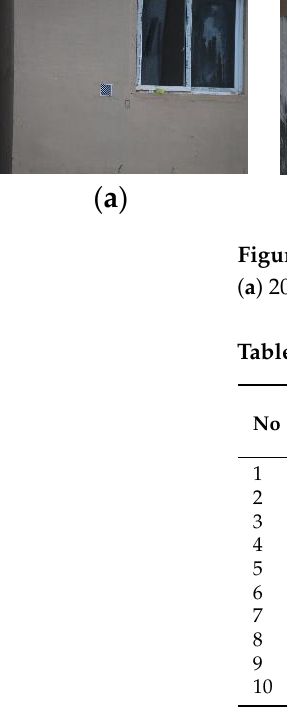
( b ) Figure 18. Five artificial cracks: ( a ) original image with measured width; ( b ) segmentation results of the proposed method.